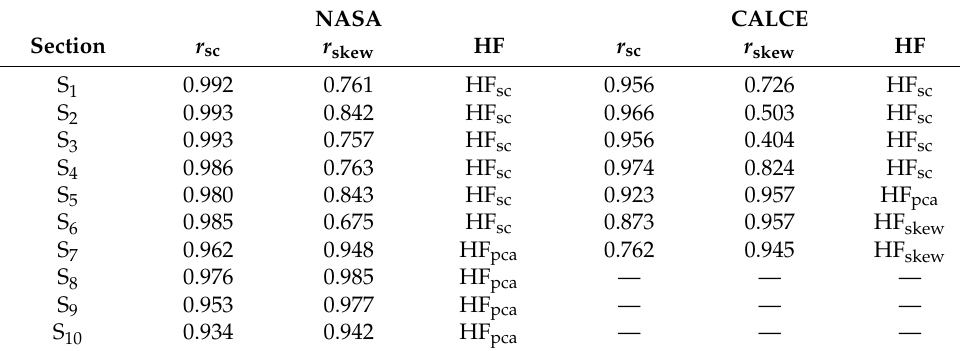
Table 2. Results of health factor